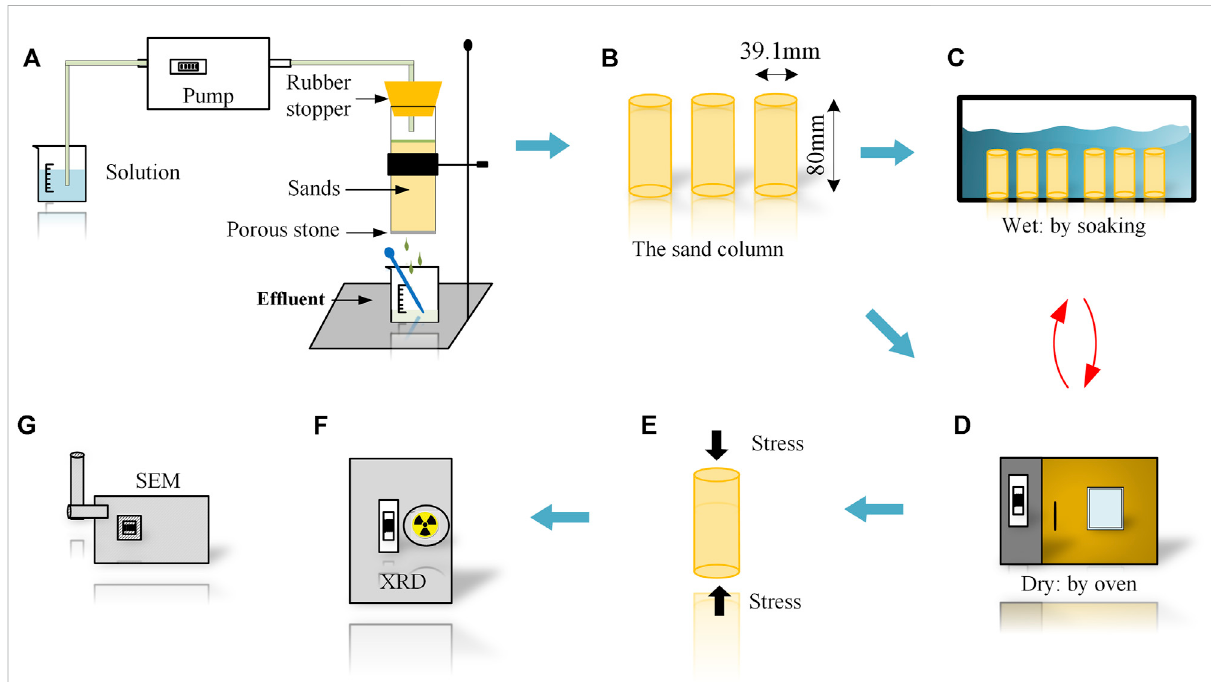
FIGURE 2 EICP treatment method: (A) one-phase injection of EICP treatment; (B) separation of specimen and PVC mold; (C) soaking treatment of demoldedspecimen; (D) ovendryingofdemoldedspecimen; (E) loadingofdemoldedspecimen; (F) X-raydiffractiontest;and (G) Scanningelectron microscope test.